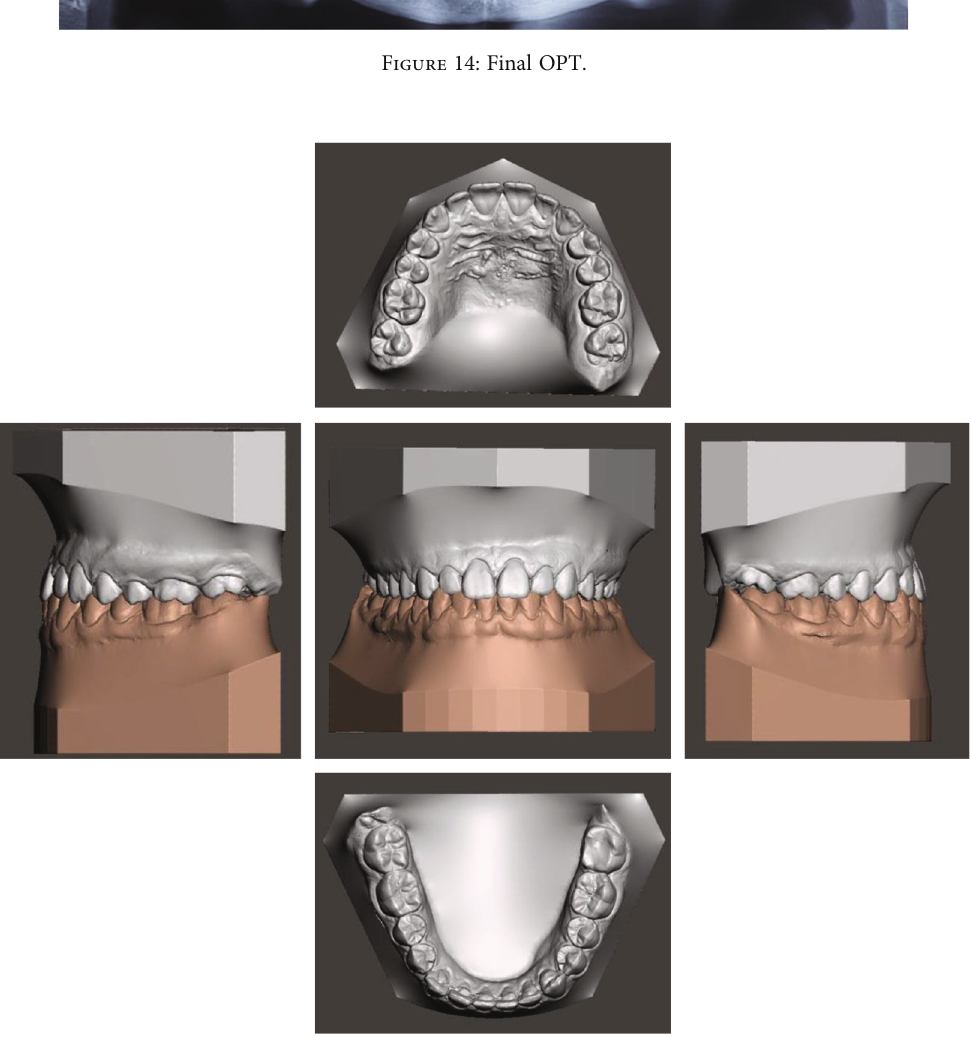
Figure 15: Final virtual